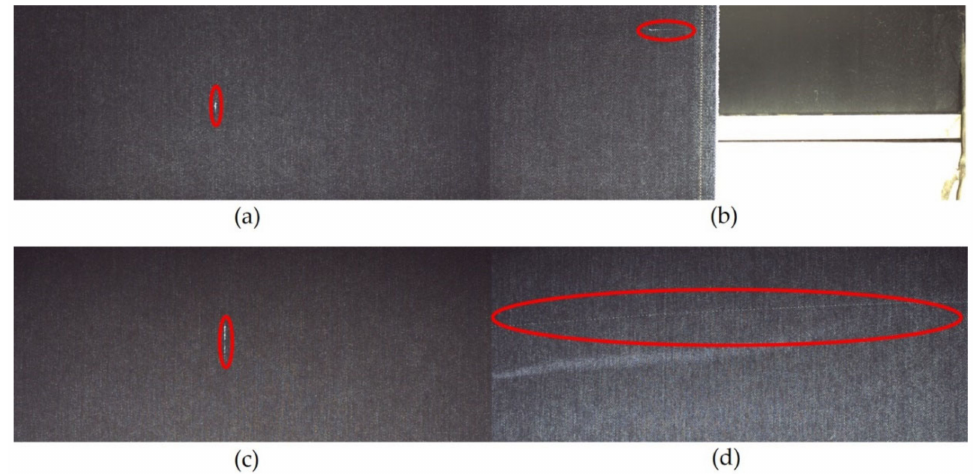
Figure 7. Defects of the denim fabric. ( a ) knot, ( b ) coarse warp, ( c ) three wire, and ( d ) flower jump.